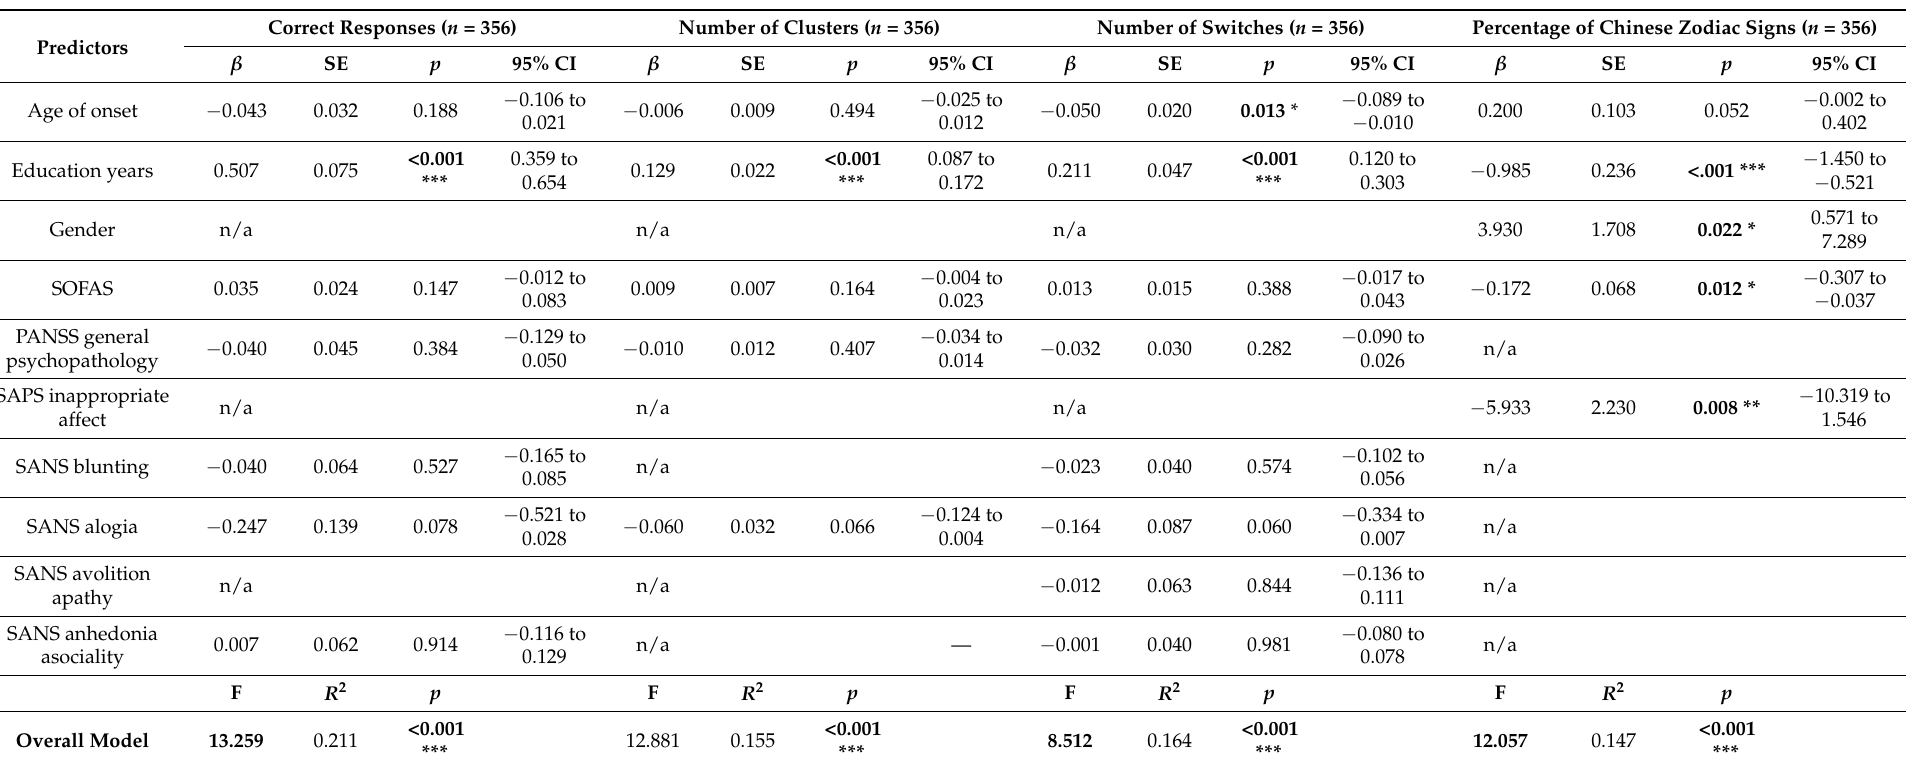
Table 3. Multiple linear regression analyses of factors related to category fluency performance in